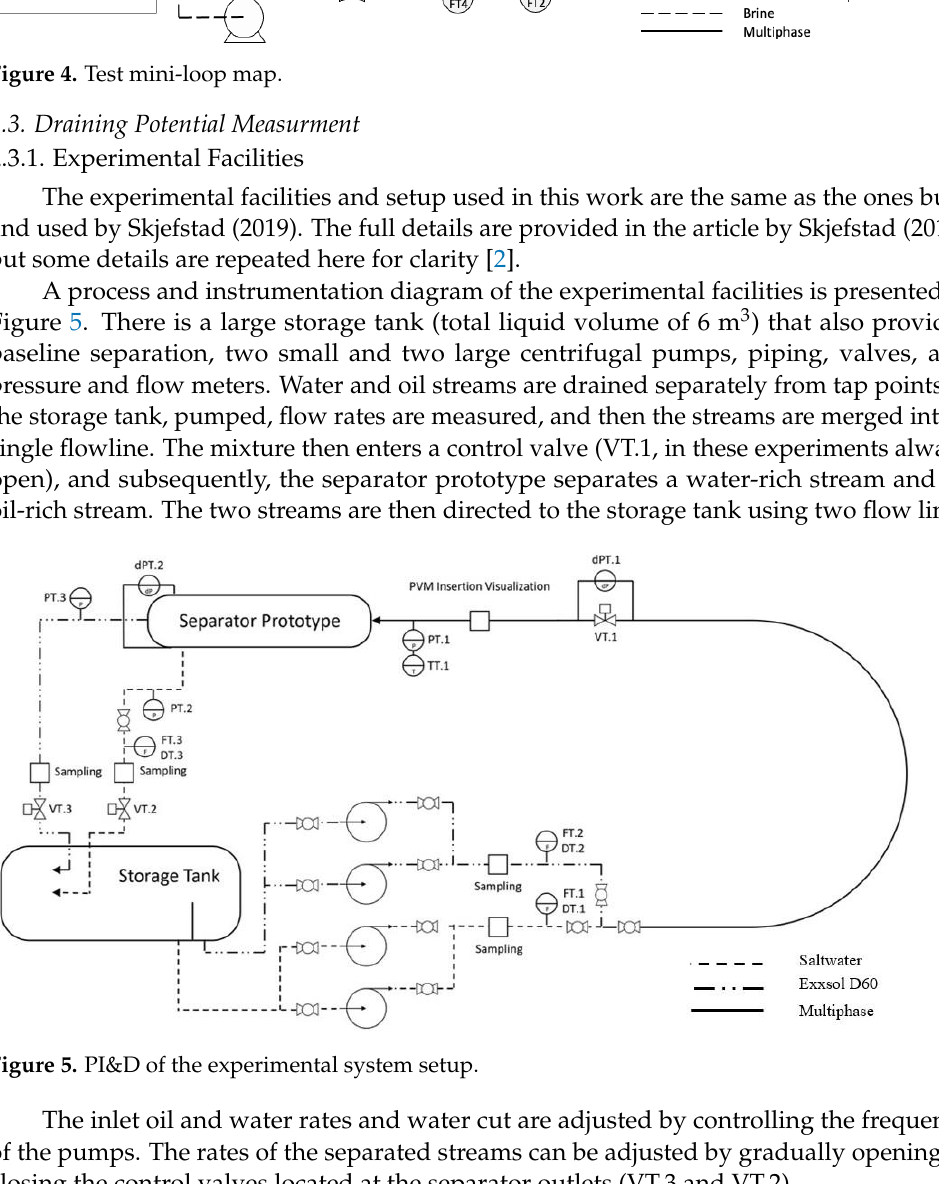
Figure 5. PI&D of the experimental system setup.